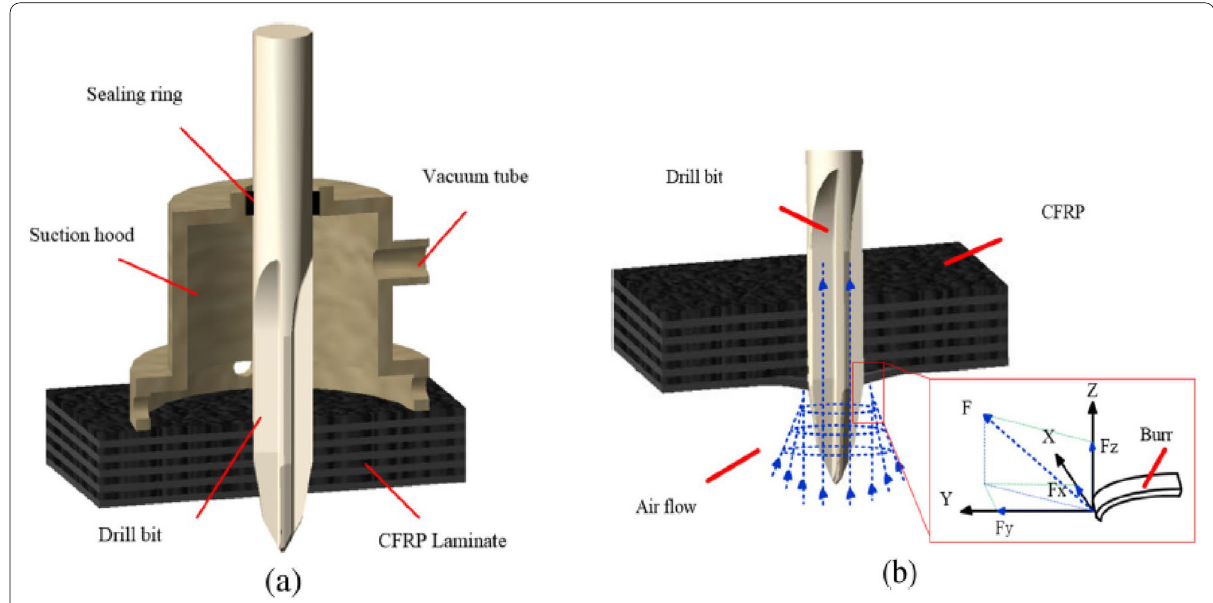
Figure 31 Schematic diagram of reverse-air cooling technology: a Setup, b Principle